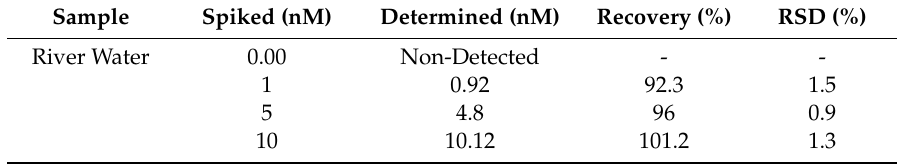
Table 2. Recovery studies of E2 in the river water samples (Langat river) by using CDs/SPCE interface.